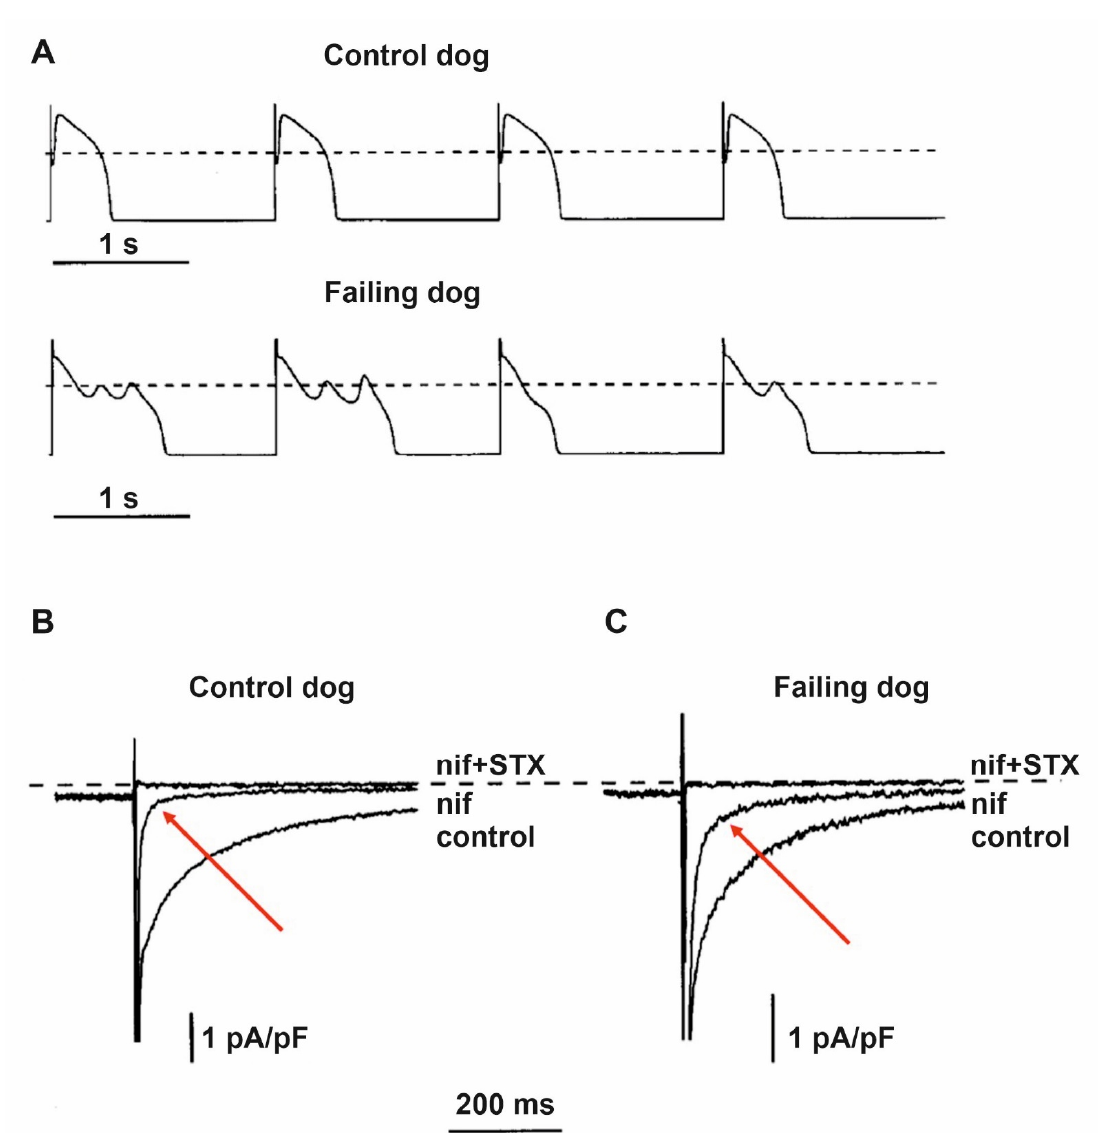
Figure 5. Increased late sodium current (I NaL ) and repolarization abnormalities in dogs with heart failure. ( A ) Representative action potential recordings from ventricular myocytes isolated from normal and failing canine hearts. The action potentials in failing hearts exhibited prolonged duration, reduced notch, and early afterdepolarizations. Representative original inward current recordings from ( B ) normal and from ( C ) failing dog ventricular myocytes show significantly larger saxitoxin (STX; 1 µ M) sensitive inward current following the application of the Ca 2+ channel blocker nifedipine (indicated with red arrows; nif; 2 µ M). The dashed line indicates zero current level